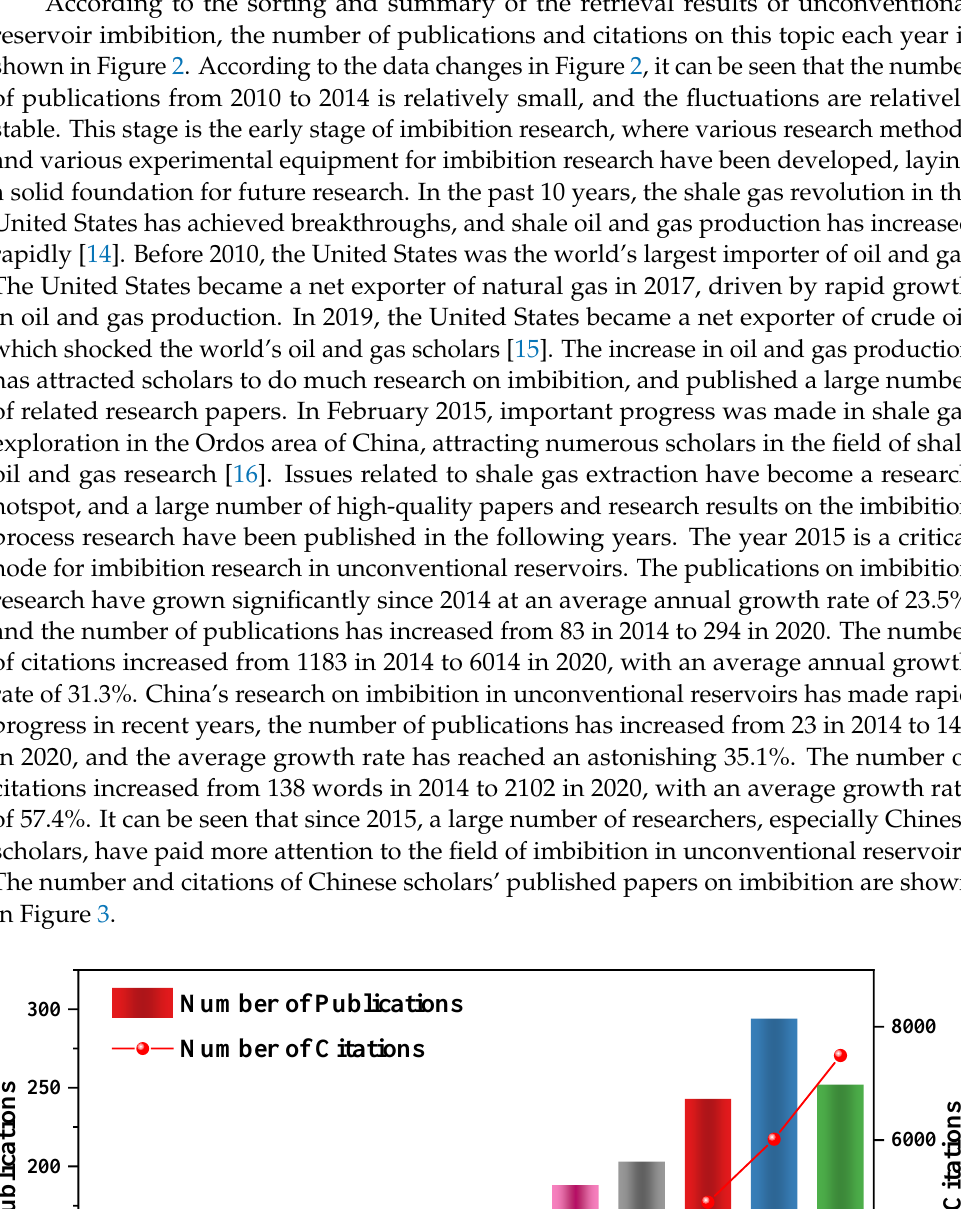
Figure 3. Number of publications and citations from 2010 to 2021 in China. With the development of globalization, academic exchanges and cooperation networks are becoming more and more frequent. Identifying and summarizing cooperation relationships at various levels is helpful to understand the current status of unconventional reservoir imbibition research cooperation. Using Citespace software, the national cooperation network, institutional cooperation network, and author cooperation network are established through the analysis of published articles, and the cooperation relationship is explained from the macro- and micro-levels. In the graph obtained after scientific analysis, the node size represents the total number of articles published by countries, institutions, or authors, and the thickness of the links represents the strength of the cooperative relationship in the cooperative analysis graph. 3.1.1. Analysis of National Cooperation Figure 4 is a map of the national cooperation network for imbibition research in unconventional reservoirs. According to the size of the nodes in the map, the leading countries in this field can be identified. The five countries with the largest number of publications are China (688 papers), the United States (560 papers), Canada (182 papers), Australia (119 papers), and Iran (104 papers). A large number of published papers show that these countries have made different degrees of progress in research in this field, and